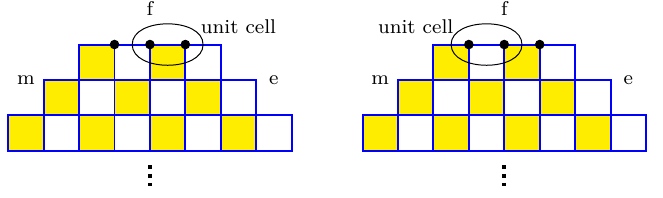
Figure 7 . There is an odd number of Majorana modes shared between the e − f and f − m junction. √ 2 in the quantum dimension of the defect in the e − f or m − f junction. Nonetheless,